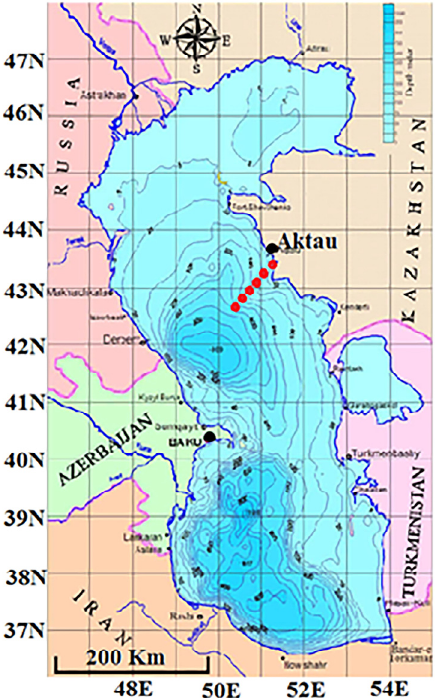
Figure 1. Map of the Caspian Sea showing the study area in the eastern part of the Middle Caspian Sea ( Study stations).